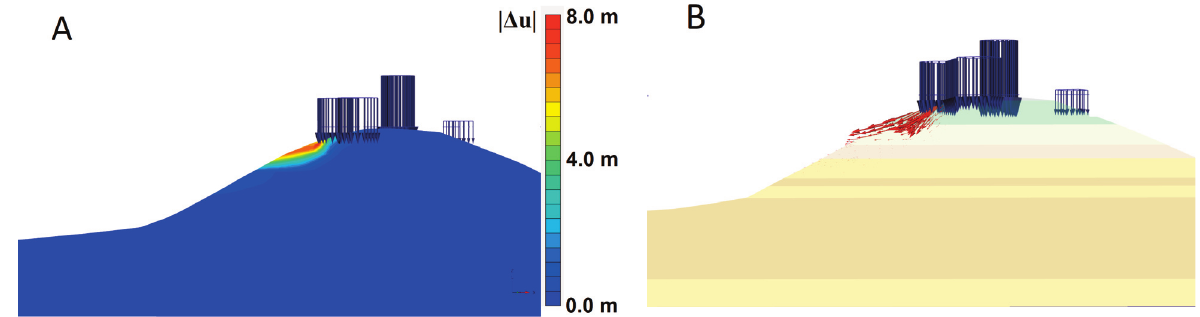
Fig. 5. The modelled sliding surface in the most landslide-susceptible section in Devonian bedrock visualized through shadings of the total displacement increments (| Δ u|) ( A ) and displacement vectors ( B